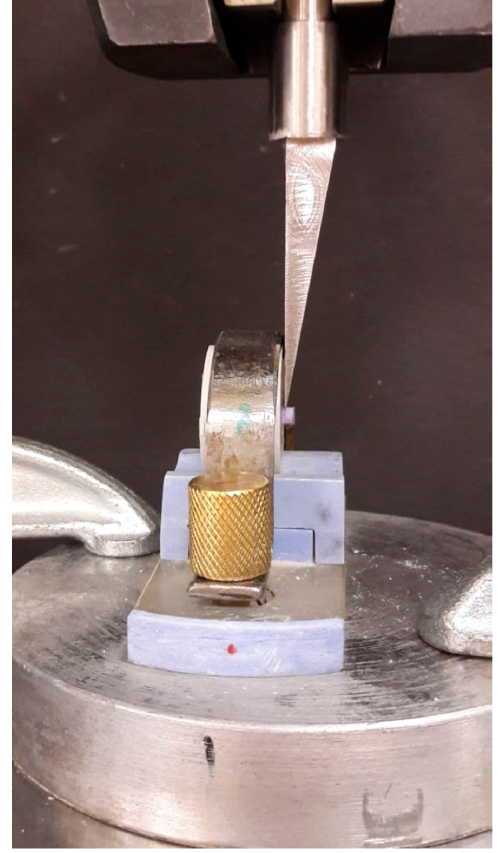
Figure 4. Macro shear bond strength evaluation with INSTRON.